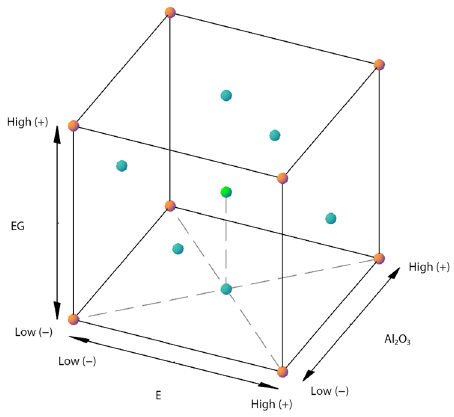
Figure 2. Geometric view of the FCCCD. Table 1. Design matrix of the FCCD.